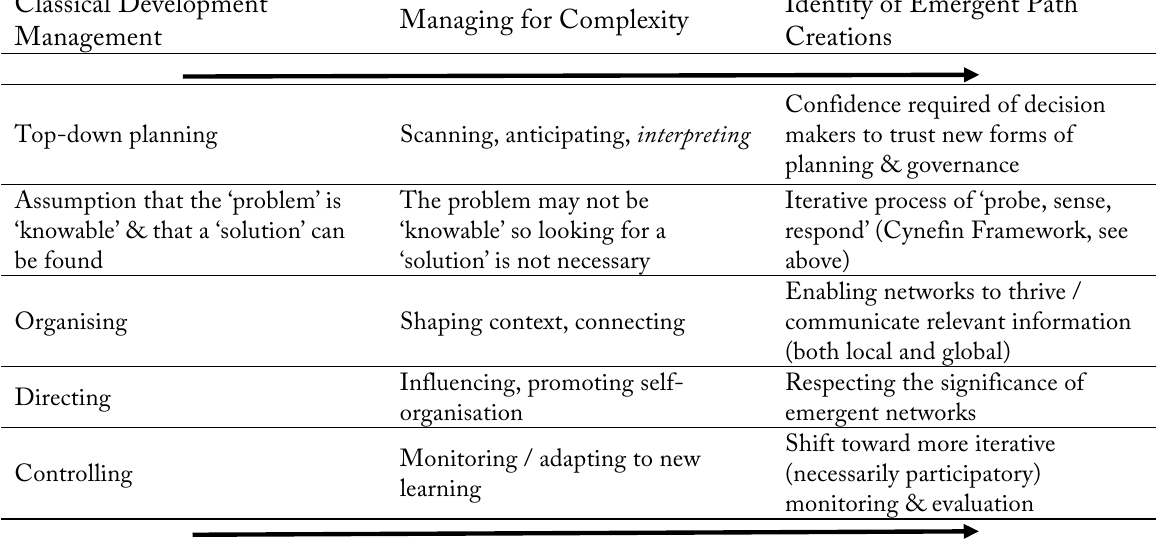
Table iii: Managing for complexity. Source: adapted from Project Leader's Team (2012: